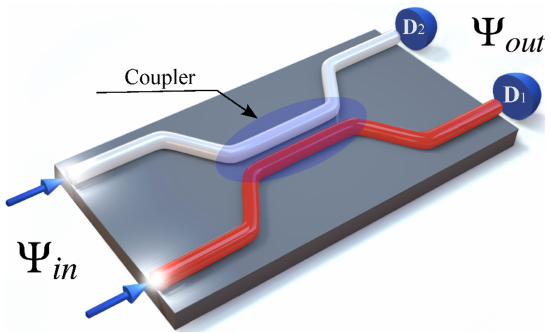
Figure 1. 3D representation of the waveguide BS. Photons (in the general case nonmonochromatic) fall on the input ports BS. At the output ports of the BS are detectors D 1 , D 2 registering photons. The figure highlights the coupling region of the waveguide, where the electromagnetic fields from ports 1 and 2